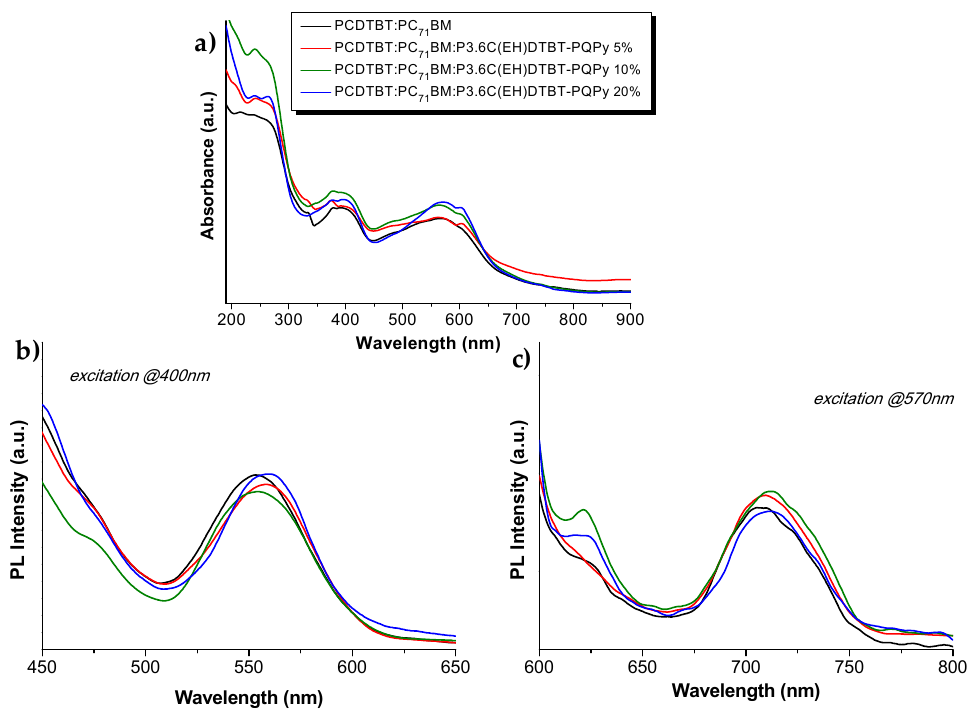
Figure 5. ( a ) UV-Vis specta; ( b ) PL spectra upon excitation at 400 nm; and ( c ) PL spectra upon excitation at 570nm of the PCDTBT:PC 71 BM:P3,6C(EH)DTBT-PQPy blends of spin-coated films.